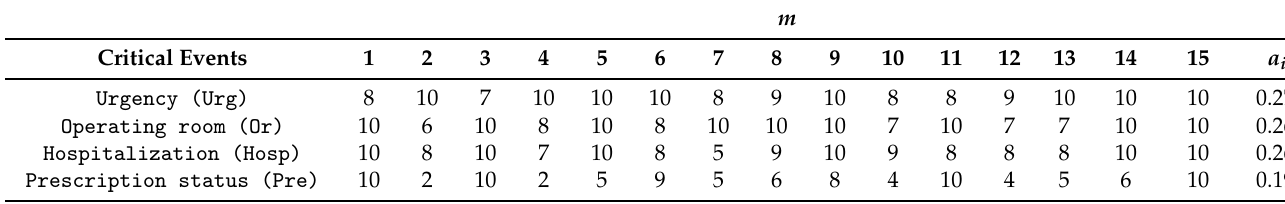
Table 3. The 15 physicians assigned relevance scores to the four critical events.